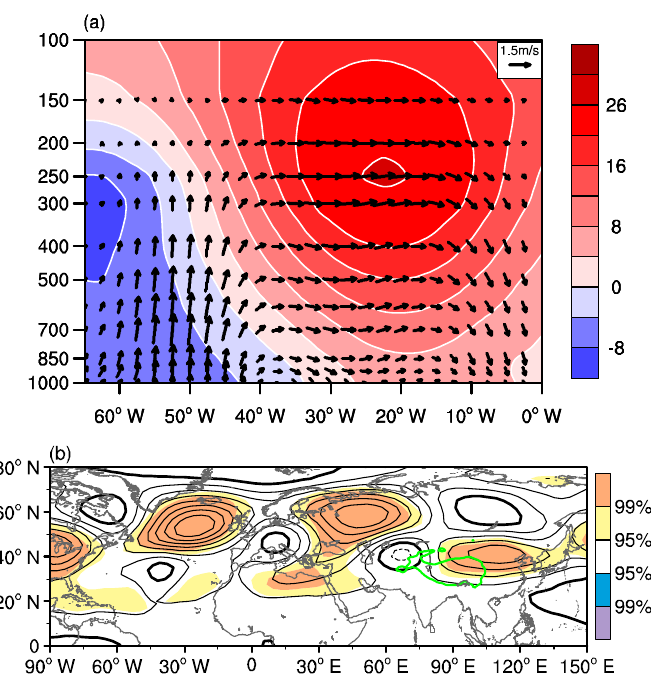
Figure 7. ( a ) Summer geopotential height (units: gpm; contours and shading) and the zonal–vertical circulation (black vectors) anomalies along 60° N obtained by regression on the April high-latitude North Atlantic SST index for the period 1981–2019. ( b ) Summer 200-hPa geopotential height anomalies (units: gpm) regressed upon the April high-latitude North Atlantic SST index. Contours are drawn every 4 gpm. The bold black line is zero. The solid and dash lines denote positive and negative values, respectively. Shadings denote geopotential height anomalies significant at the 95% and 99% confidence levels as shown by the color bars.